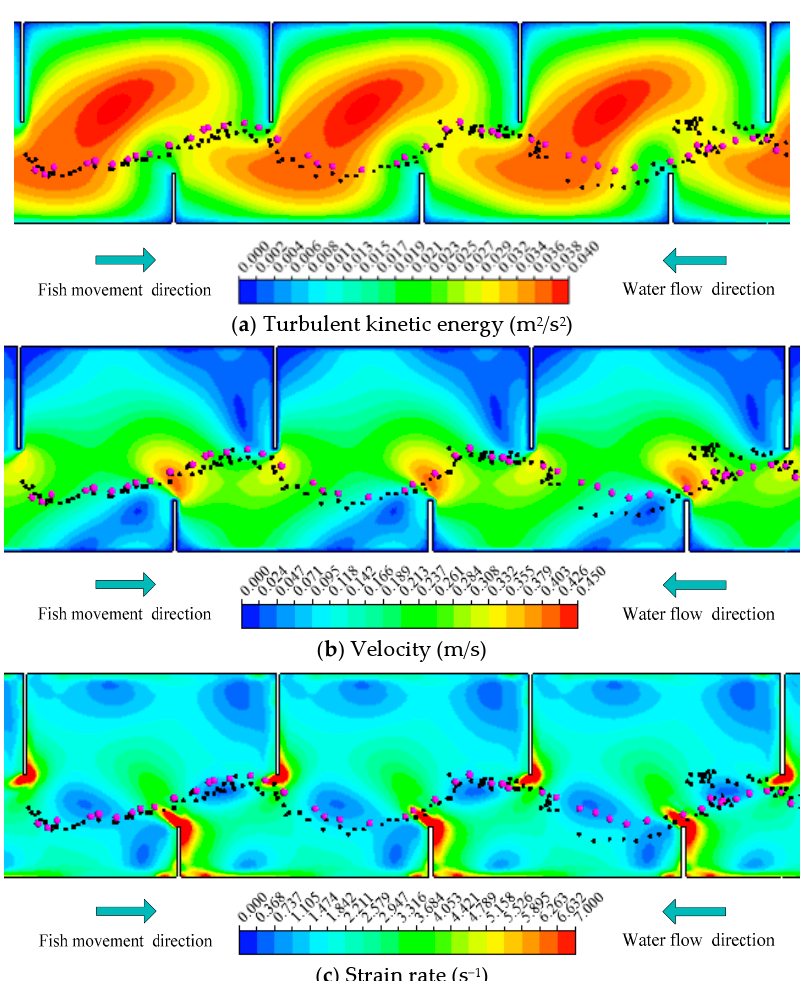
Figure 6. Representative trajectory of Fish A combined with ( a ) TKE; ( b ) V; ( c ) SR distribution in Pools 2–4 (Notes: The rose red points represent the simulated fish movement trajectories, and the black points represent the measured trajectories of fish).